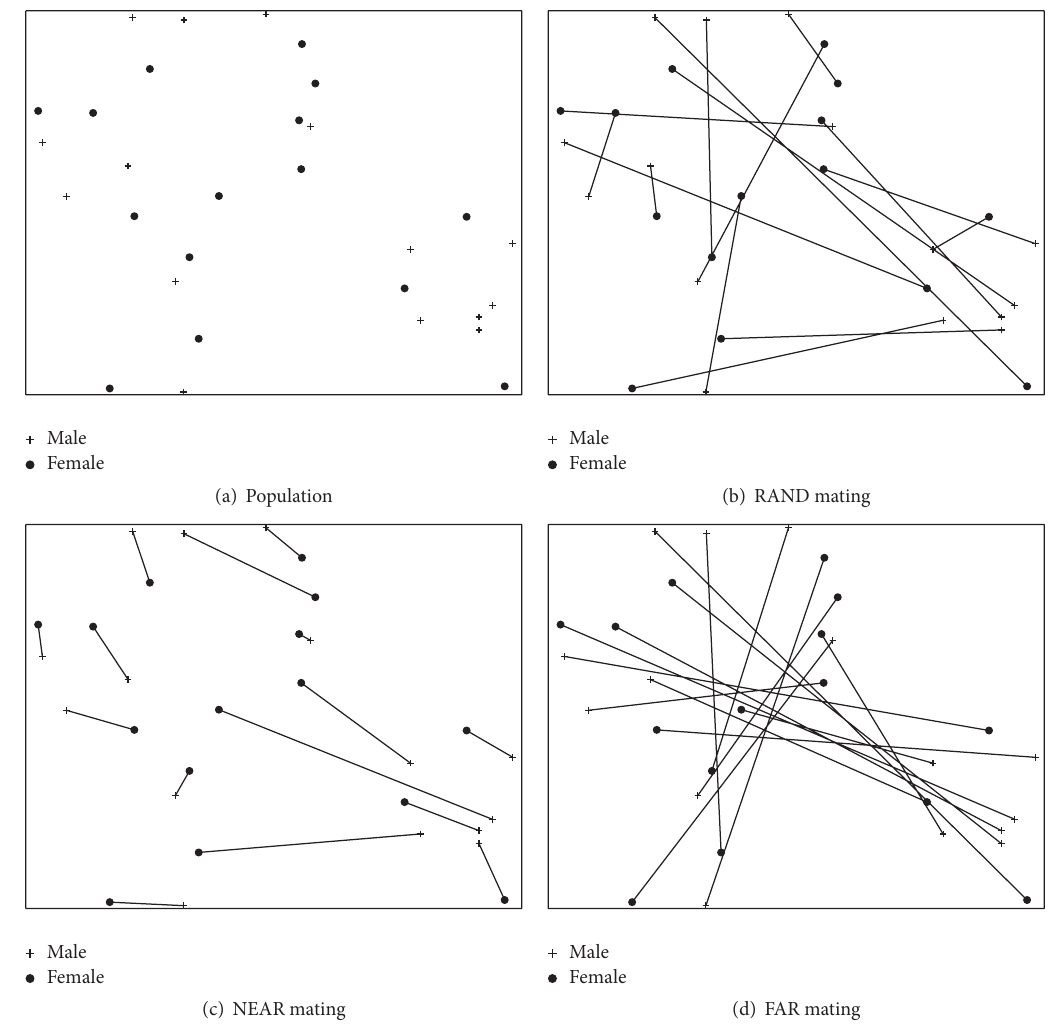
Figure 1: Hungarian mating schemes